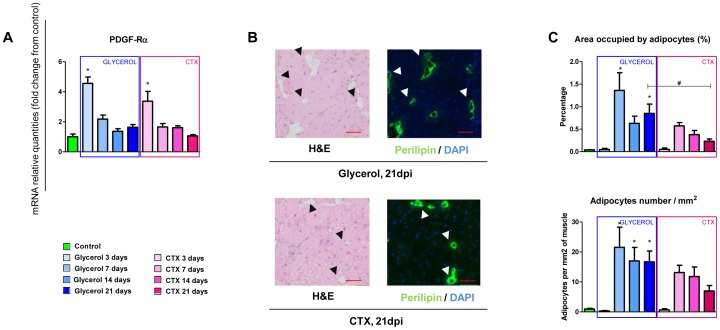
Ectopic adipogenesis occurs in both glycerol- and CTX-induced muscle regeneration.(A) qPCR analysis of the mRNA level of the platelet-derived growth factor receptor alpha (PDGFRα). (B) Cryosections were performed at the mid-belly part of TA and subjected to H&E and perilipin staining at each time points after injection. Representative perilipin (green) /DAPI (blue) fluorescent stainings at 21 dpi are shown next to an H&E staining of the same region. Scale bars, 50 μm. (C), Quantitative analysis of perilipin expression assessed by counting and measuring the area of all perilipin expressing cells per section. Data are expressed as mean ± s.e.m., n = 5–6/group. * p-value <0.05 vs. control, # p-value <0.05 in Glycerol vs. CTX at same time points.